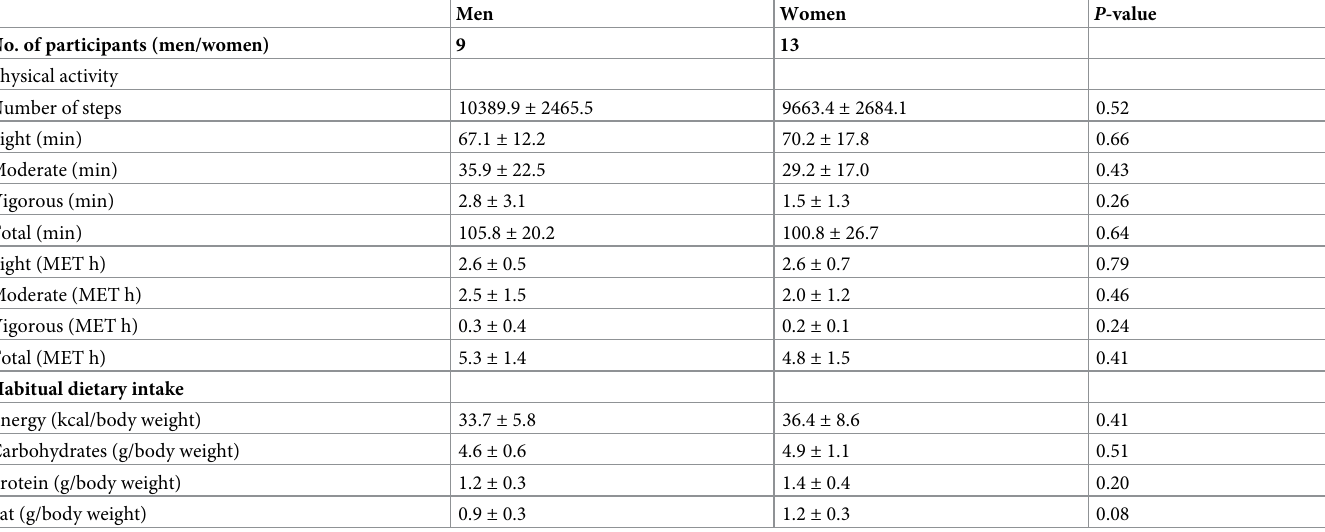
Table 2. Physical activity and dietary habit characteristics.